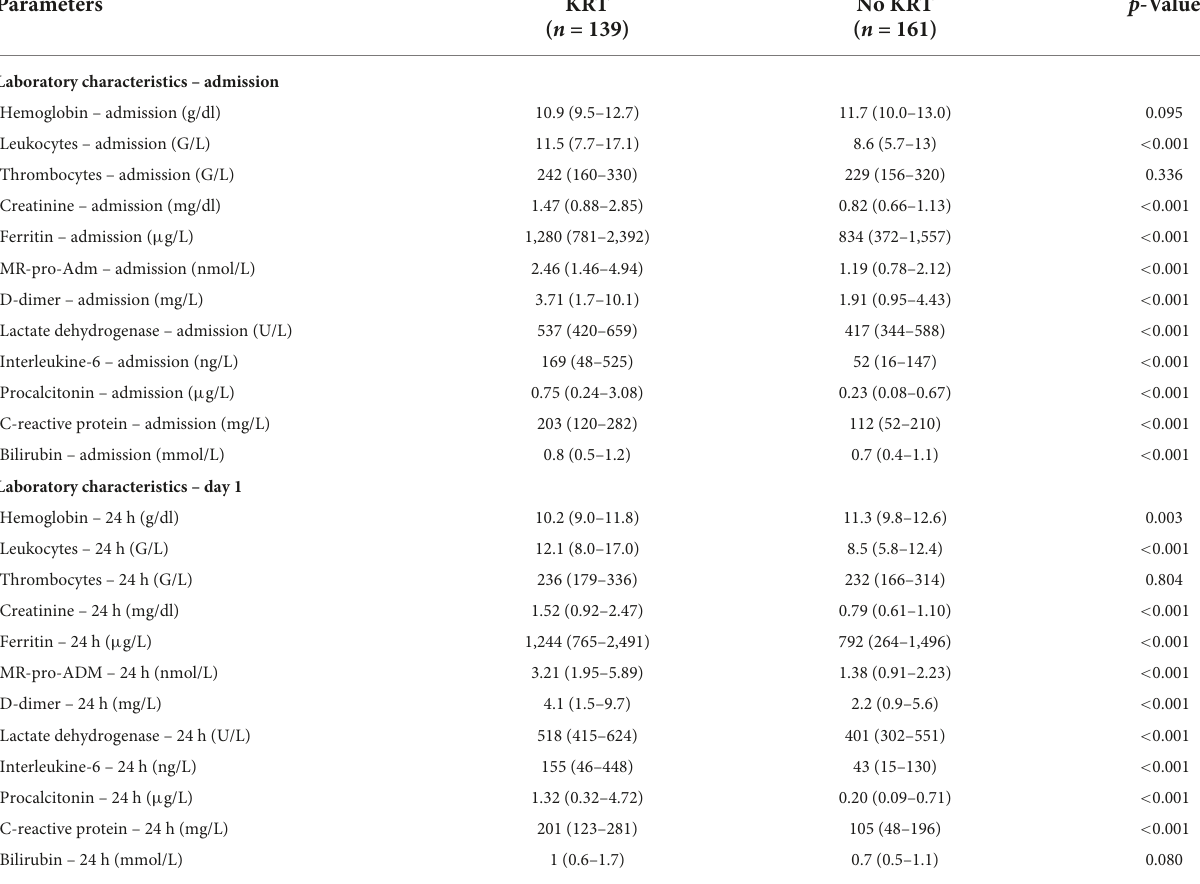
TABLE 4 Laboratory characteristics on admission and after 24